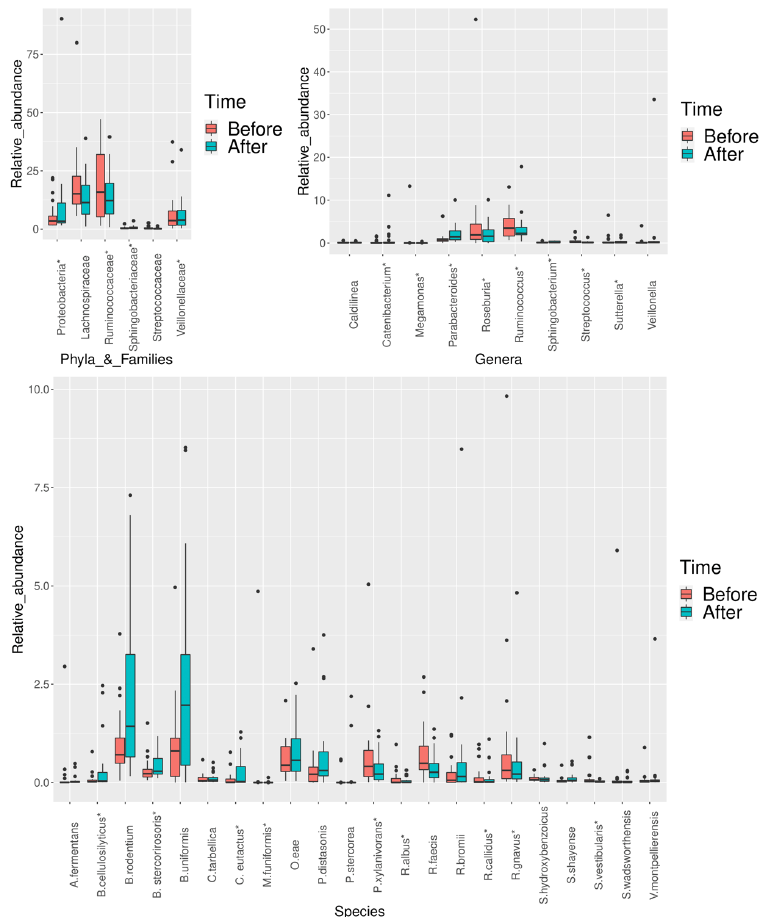
Figure 2. Statistically significant di ff erences in bacterial relative abundance in obese and overweight patients after the nutritional intervention, at the phylum, family, genus, and species levels, respectively. The significance level was obtained by performing the Wilcoxon test for paired data. p -values were adjusted for False Discovery Rate (FDR) (FDR < 0.05). A change in twenty-four taxa was found when considering the FDR adjustment (as indicated by the asterisk). In the box plots, the boundary of the box closest to zero indicates the 25th percentile, a black line within the box marks the median, and the boundary of the box farthest from zero indicates the 75th percentile. Whiskers above and below the box indicate the 10th and 90th percentiles. Points above and below the whiskers indicate outliers outside the 10th and 90th percentiles. Each group is identified by colors, as indicated on the right side of the figure (before intervention = pink, after intervention = light blue). Every sample is represented by a black